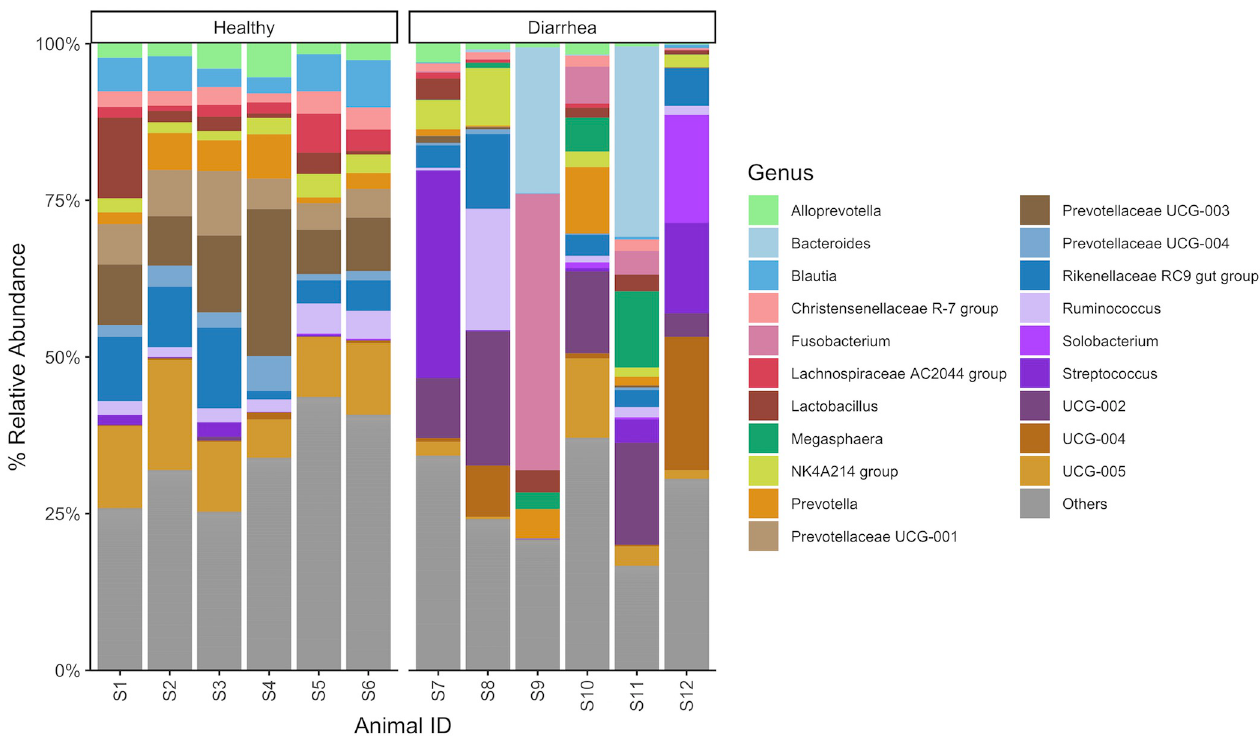
Fig 8. Relative abundance of the top 20 genus in cecal samples of healthy horses and horses with diarrhea.